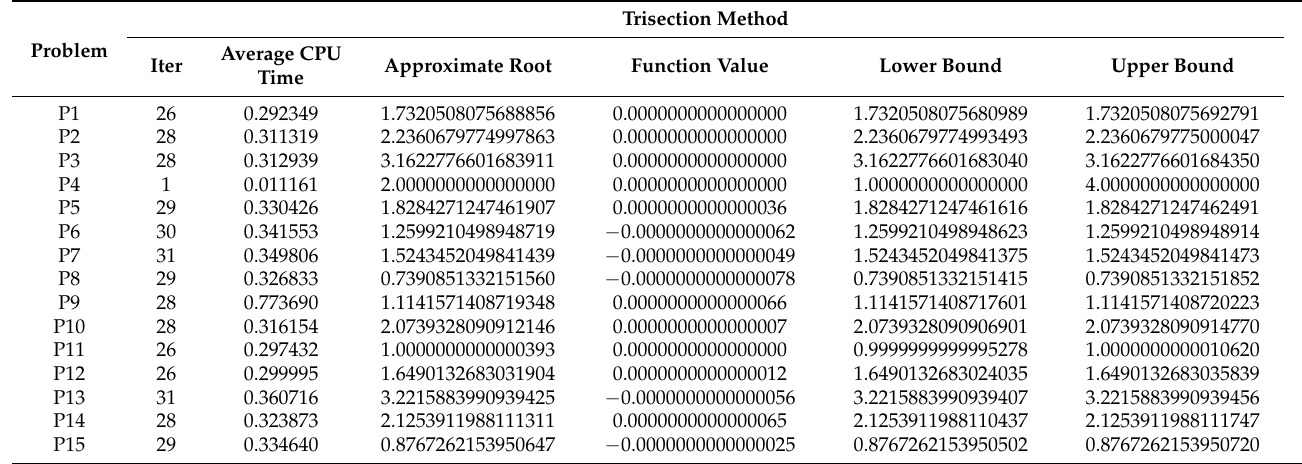
Table 4. Solutions of fifteen problems by the trisection method.